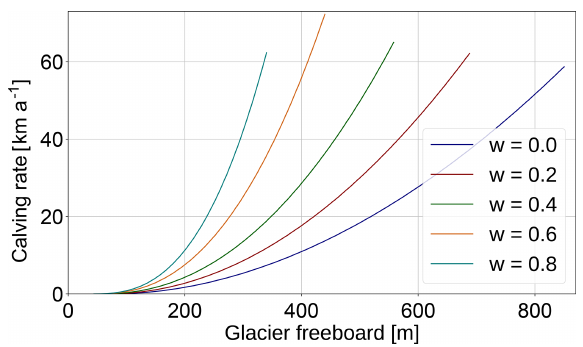
Figure 7. Cliff-calving rates C as a function of glacier free- board F = H − D and relative water depth w = D/H , as given by Eq. (23).